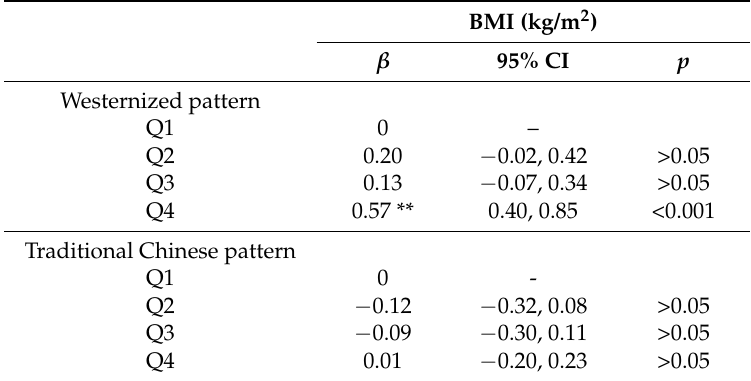
Table 4. Multivariate linear regression model to evaluate the effect of dietary pattern scores on BMI in Chinese children and adolescents ( β Coefficients and 95% confidence intervals). BMI (kg/m 2 )